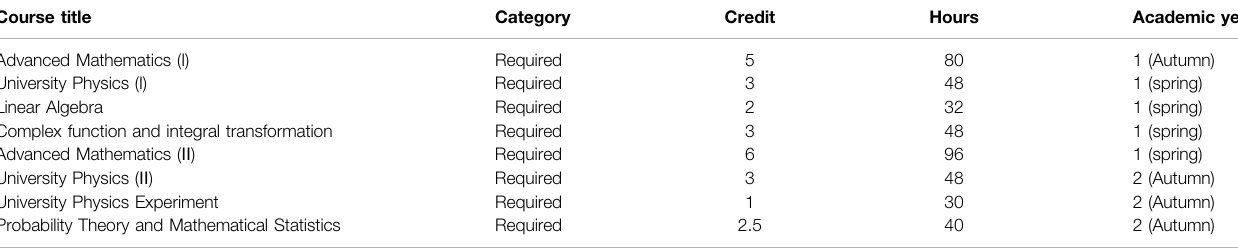
TABLE 1 | Curriculum setting of mathematics and natural science courses.